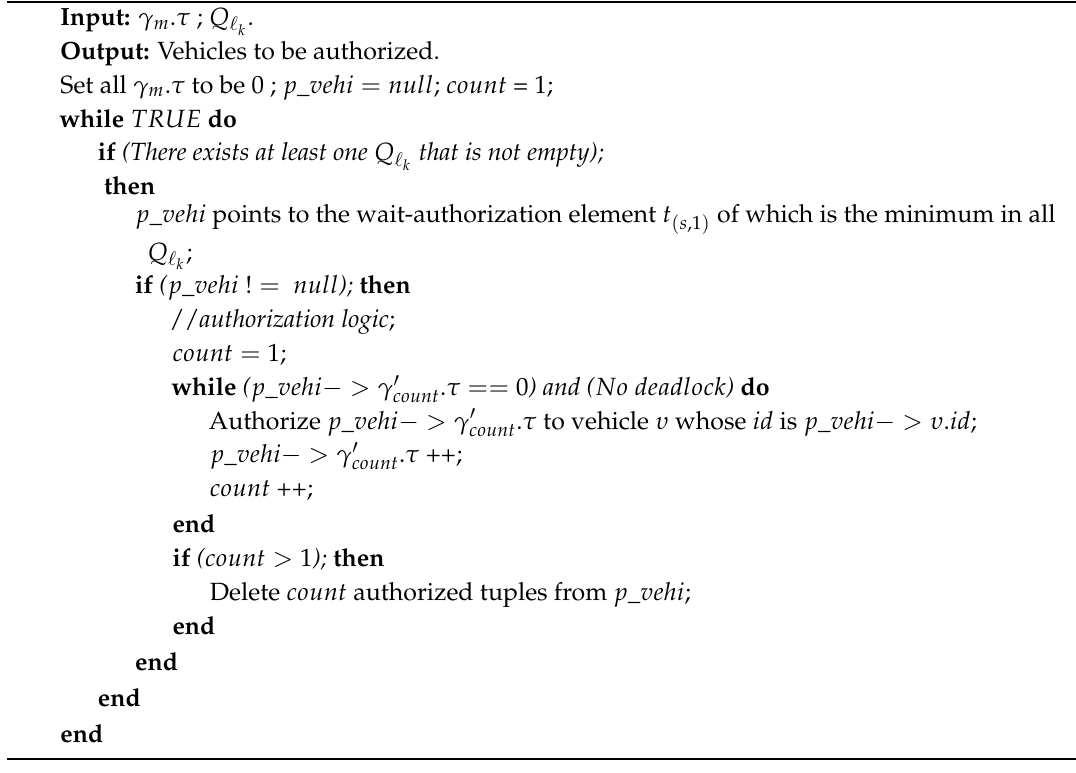
ALGORITHM 1: Arrival Time-based Authorization Mechanism with FAFP